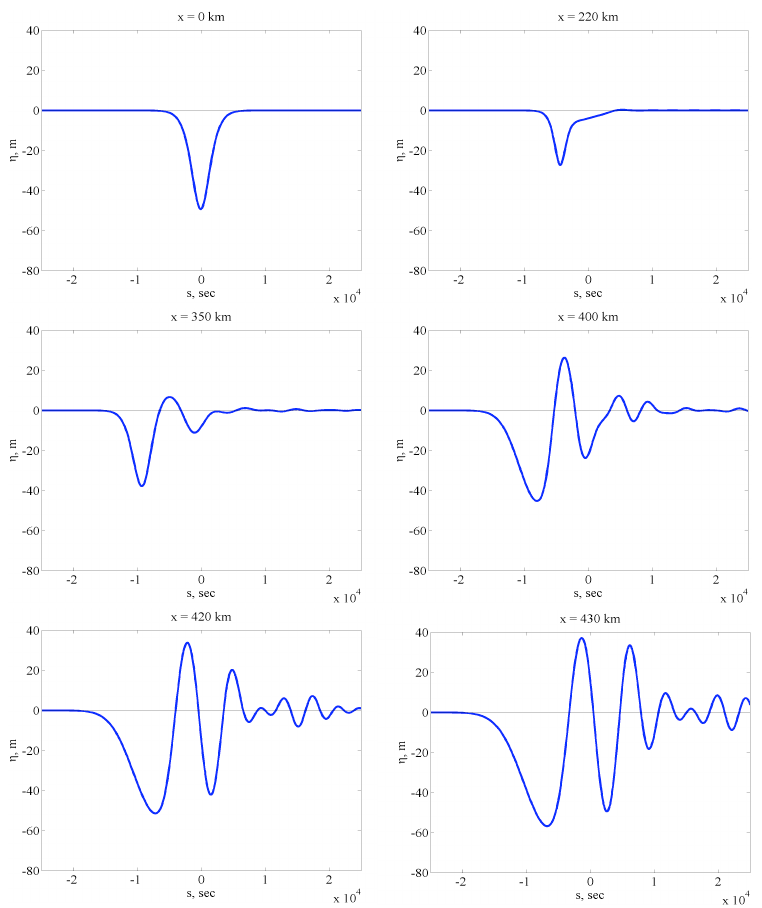
Fig. 13. Transformation of an internal solitary wave along cross-section 1.